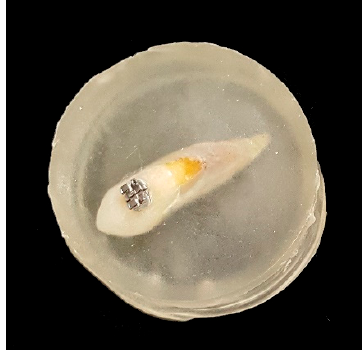
Figure 1. A tooth with a metal bracket bonded on, embedded in acrylic resin for the mechanical testing of debonding force.